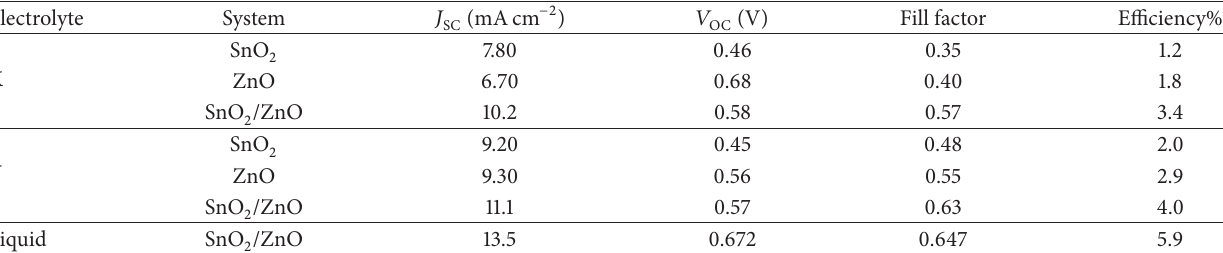
Figure 5: IPCE curves of the QSDSCs fabricated with composite systems: (a) ZnO alone and (b) SnO 2 /ZnO with electrolytes X and Y . Table 1: IV characteristics of SnO 2 /ZnO composite DSCs.